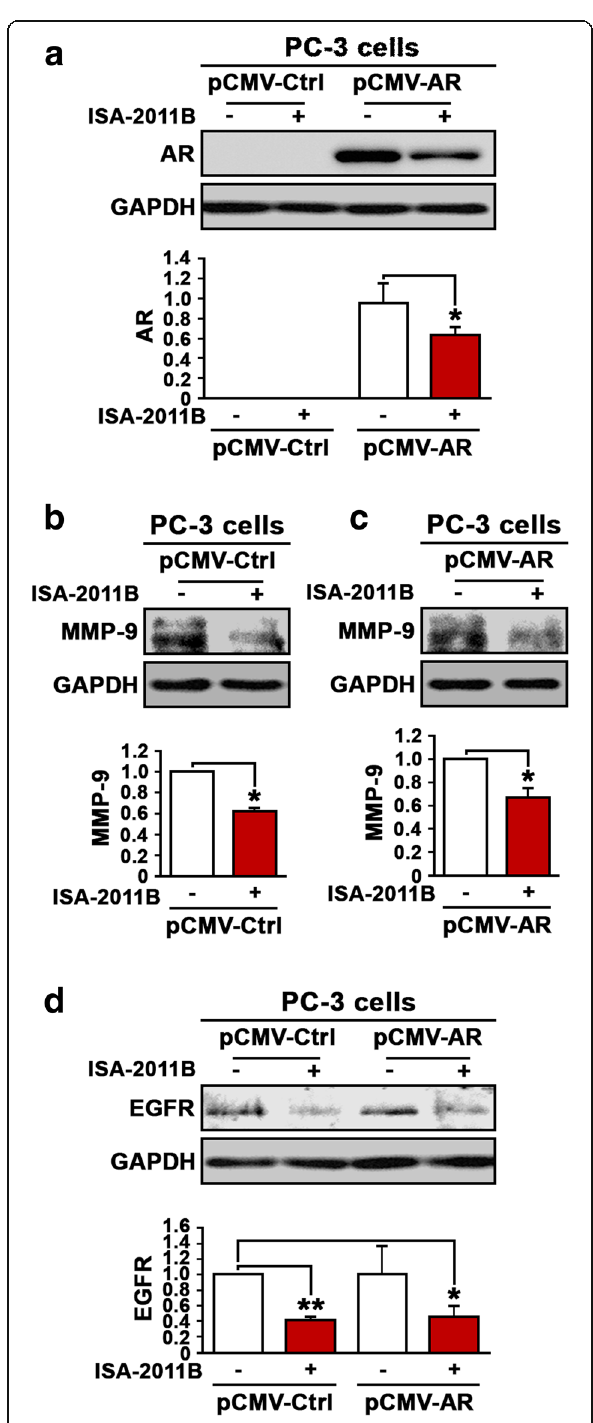
Fig. 6 The effect of inhibition of the PI3K/AKT/AR axis on the expression of AR, MMP-9 and EGFR in PC-3 cells. a Immunoblot analysis on the expression of AR in PC-3 cells that were transfected with pCMV control or pCMV-AR vectors followed by treatment with PIP5K1 α /AKT inhibitor ISA-2011B. b Immunoblot analysis on the expression of MMP-9 in PC-3 cells that were transfected with pCMV control vector followed by treatment with ISA-2011B. c Immunoblot analysis on the expression of MMP-9 in PC-3 cells that were transfected with pCMV-AR vector followed by treatment with ISA-2011B. d Immunoblot analysis on the expression of EGFR in PC-3 cells that were transfected with pCMV control or pCMV-AR vectors followed by treatment with ISA-2011B. Data presented is the average of at least two independent experiments (±SD). p <0.05 is indicated by “ * ” , p ≤ 0.01 is indicated by “ ** ” , p ≤ 0.001 is indicated by “ ***